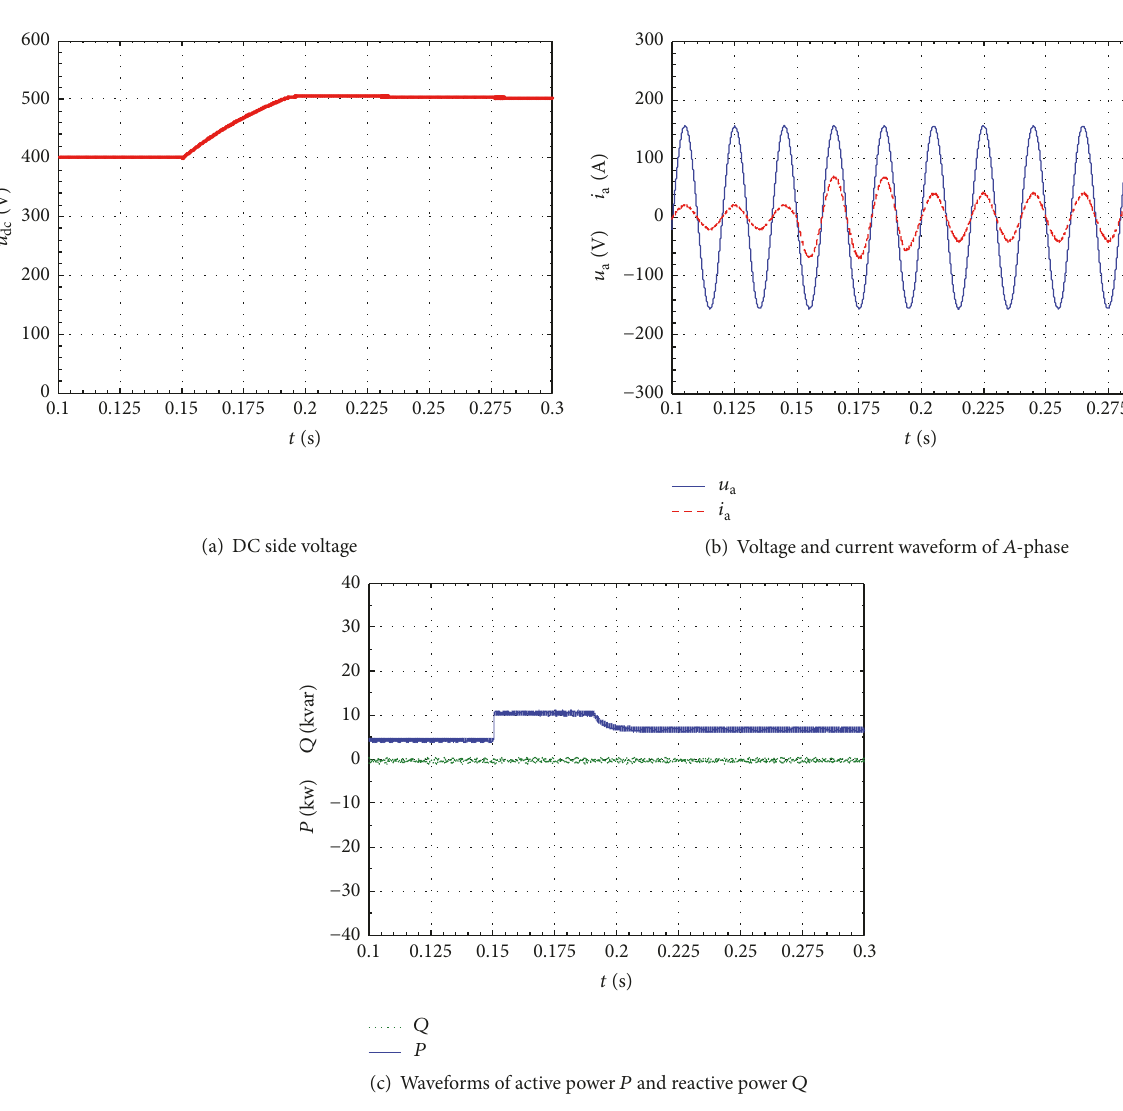
Figure 9: Waveforms when increasing DC